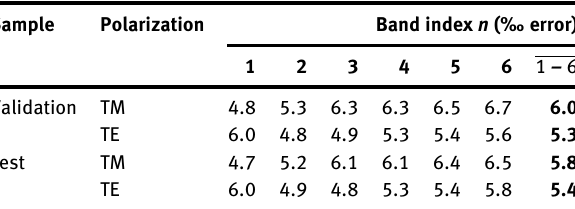
Table  : Neural network performance. Mean relative error, (cid:3)(cid:3)(cid:3)(cid:3) (cid:3)(cid:3)(cid:3)(cid:3) ω NN / ω − ω mean k n k n k , of the trained TE and TM networks on vali- n k dation and test samples, shown for each band separately as well as band-averaged (  – 